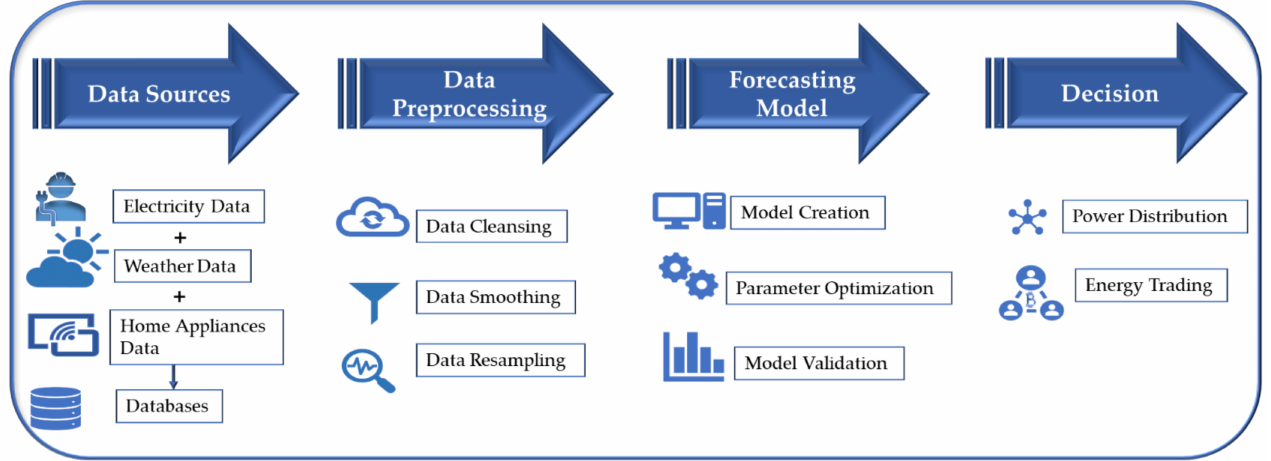
Figure 6. Framework of the proposed energy load forecasting